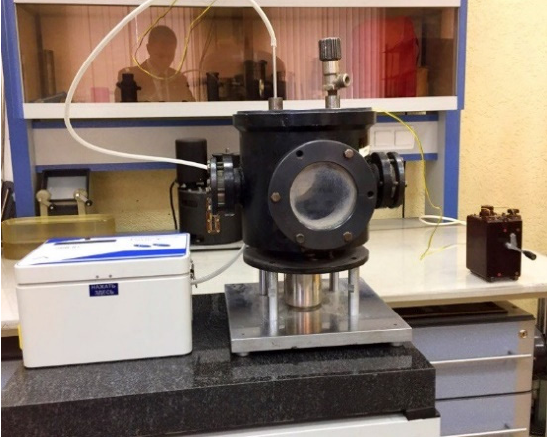
Figure 2. Laboratory setup for measuring the concentration of nitrogen oxides (photo by the author R.S. Babkin). R.S.